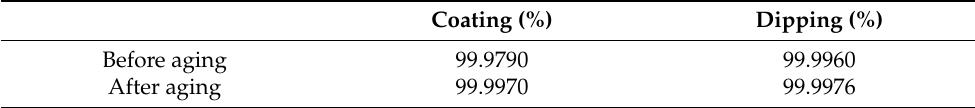
Table 5. Filtration efficiency of different surface treatment.